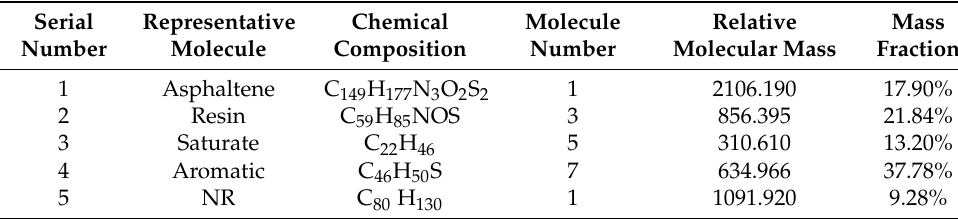
Table 2. NR-modified asphalt model.